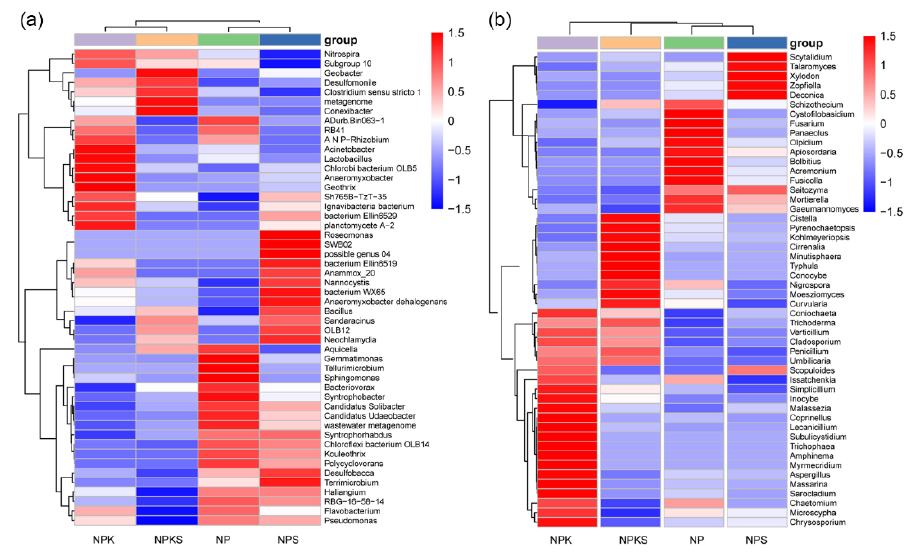
Figure 5. The dominant ( a ) bacteria and ( b ) fungi variances among the treatments at the genus level.